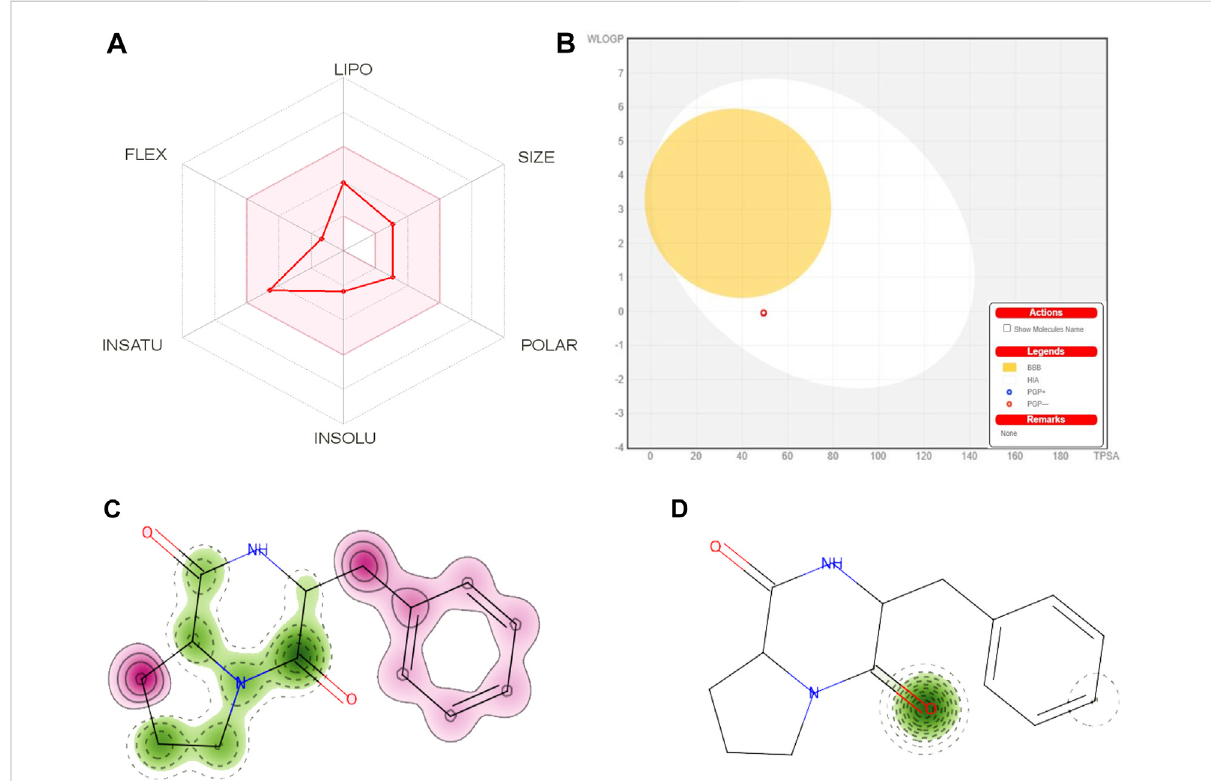
FIGURE 11 (A) A radar graphic showing CDPDP ’ s bioavailability. The pink area indicates the physicochemical region for oral bioavailability, while the red stroke shows theparameters of oral bioavailability. (B) Swiss ADME online web tool for CDPDP predicted BOILED-Egg plot. Map of skin sensitization of CDPDP obtained from pred-skin. (C) h-CLAT (D) LLNA. The positive and negative contributions of individual atoms or pieces to the skin sensitization have been identi fi ed. The bright pink hue shows that an atom and fragment have made a detrimental impact on skin